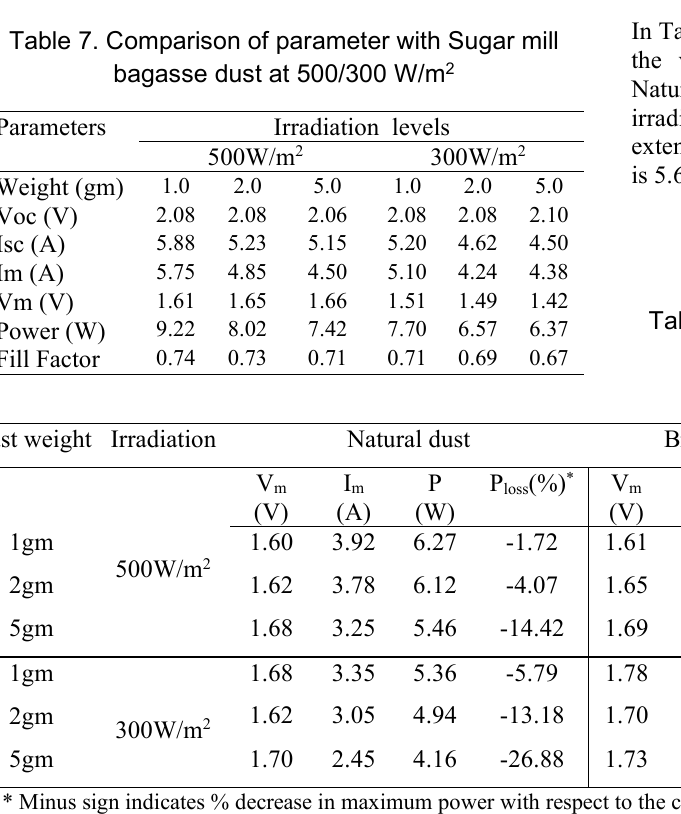
* Minus sign indicates % decrease in maximum power with respect to the clean panel (6.38